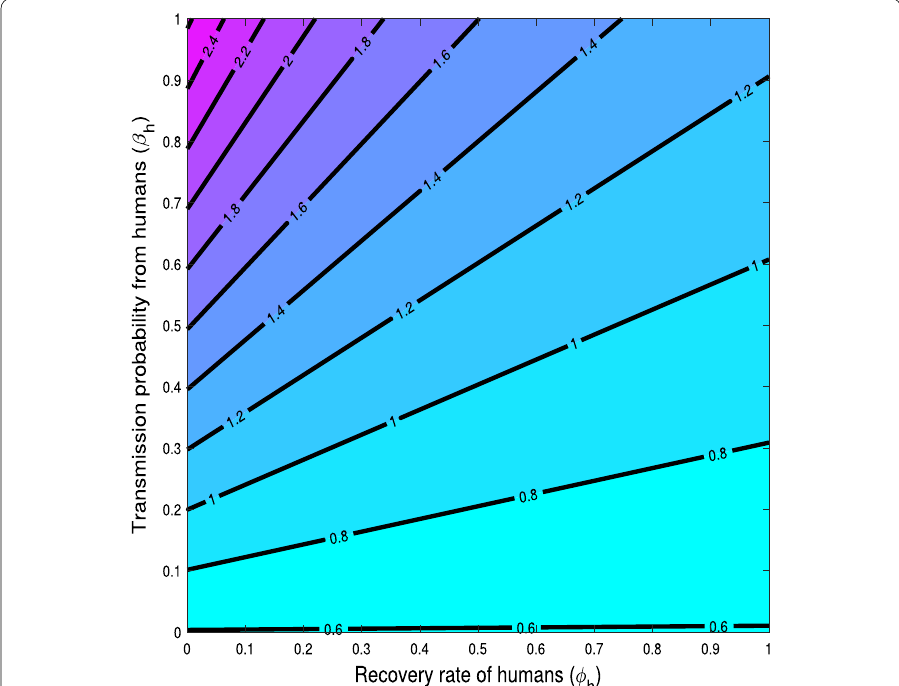
Fig. 4 2-D Contour plot of the reproduction number R 0 of Lassa fever model (1), varying recovery rate of humans with respect to transmission probability rate from humans. Parameter values used are as given in Table 2 except for δ h = 0.4887 so that R 0 = 0.7461 <